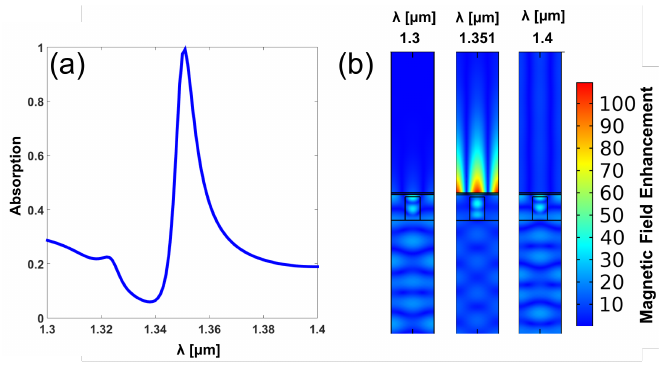
Figure 2. ( a ) Spectral absorption of the structure showing the resonance peak at λ = 1.351 µ m. ( b ) Magnetic field enhancement maps for several wavelengths ( λ = [ 1.3,1.351,1.4 ] µ